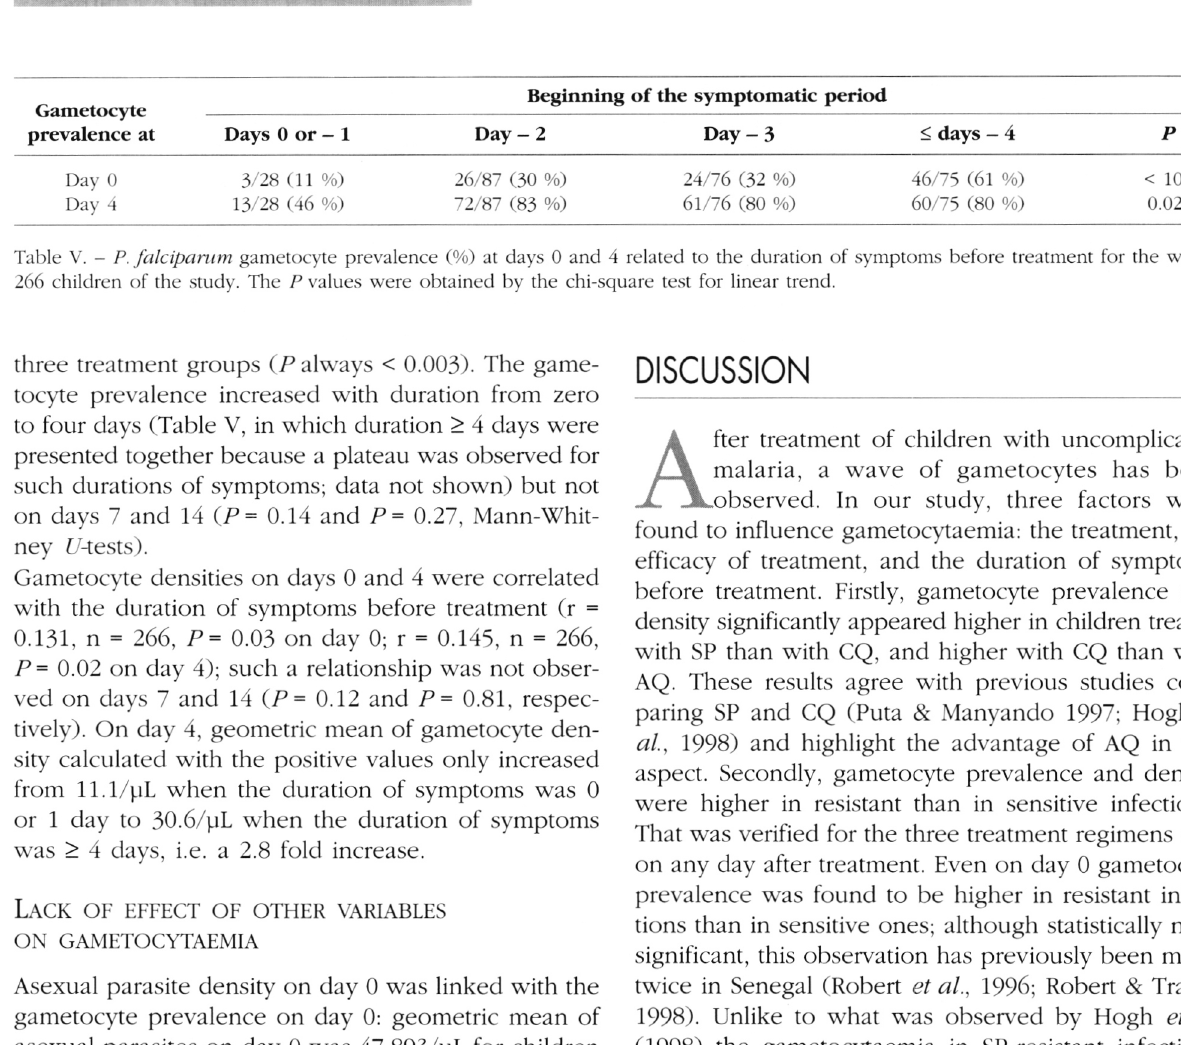
Table V. - P. falciparum gametocyte prevalence (%) at clays 0 and 4 related to the duration of symptoms before treatment for the whole 266 children of the study. The P values were obtained by the chi-square test for linear trend.